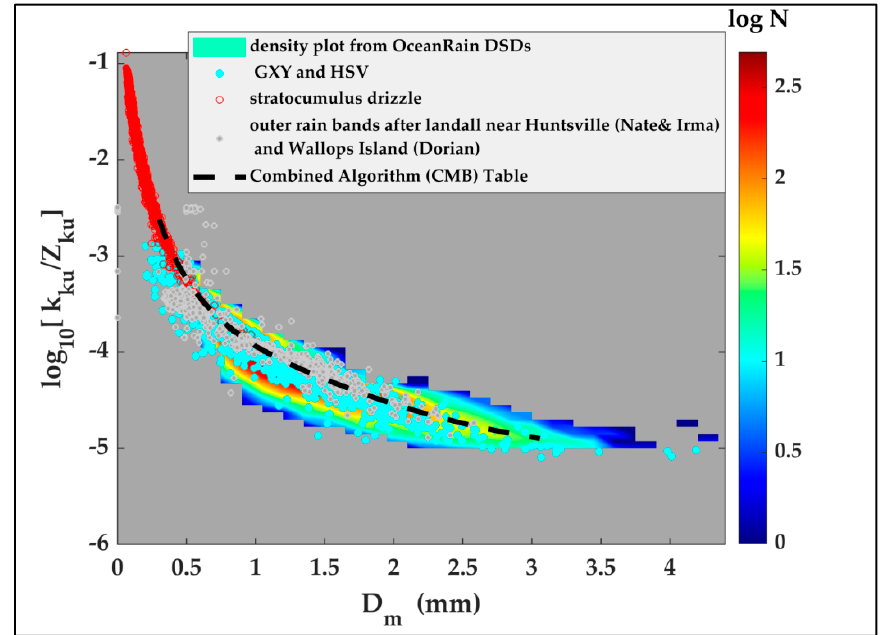
Figure 9. Ku-band-specific attenuation (k ku in dB km − 1 ) normalized by Ku-band reflectivity (Z ku in mm 6 m − 3 ) versus D m (in mm), from OceanRain DSDs, GXY-HSV DSDs, DSDs from the outer bands of Tropical Storm Irma and Tropical Depression Nate, as well as category-1 Hurricane Dorian, compared with those from the combined algorithm (CMB).